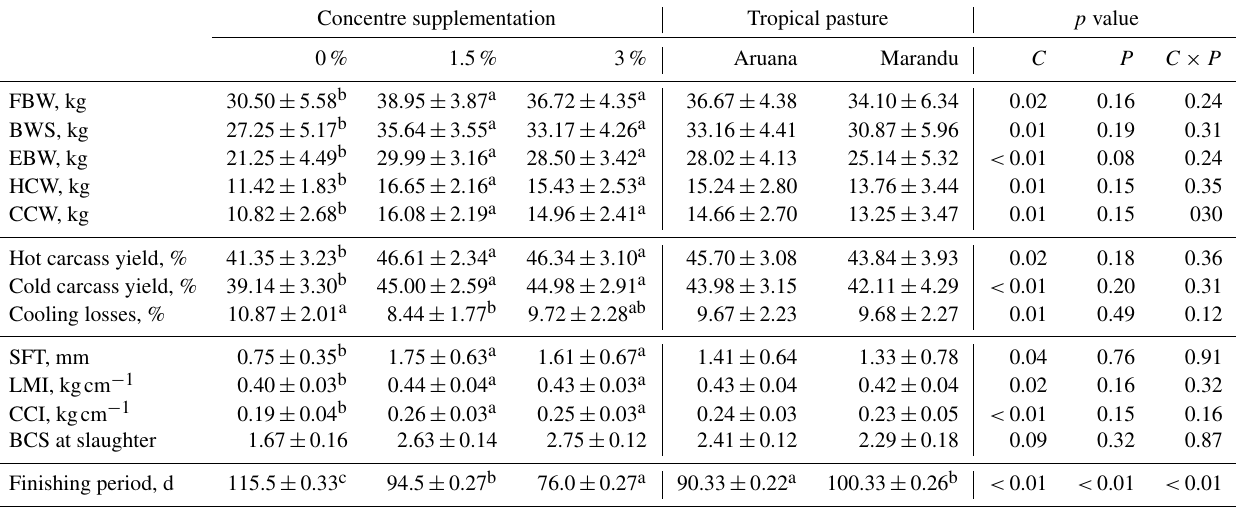
Table 3. Means, standard deviation, and effect of concentrate supplementation ( C ), tropical pasture type ( P ), and interaction ( C × P ) related to the carcass weight, yield, and indexes of Suffolk lambs.